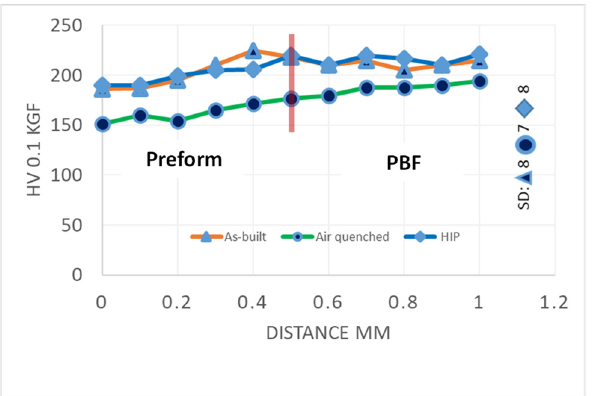
Figure 4. The results of micro-hardness test for all three sets of samples, the red vertical bar shows the interface location; SD: Standard deviation.